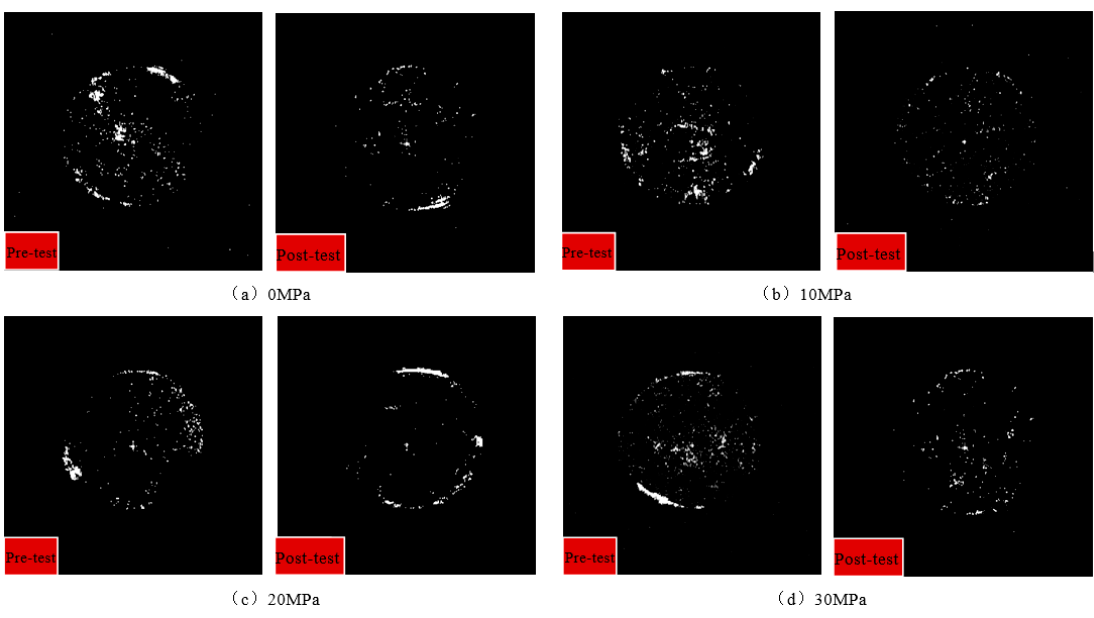
Figure 8. Nuclear magnetic resonance (NMR) images of rock samples uder different axial pre-stresses ( a ) 0 MPa, ( b ) 10 MPa, ( c ) 10 MPa and ( d ) 30 MPa.